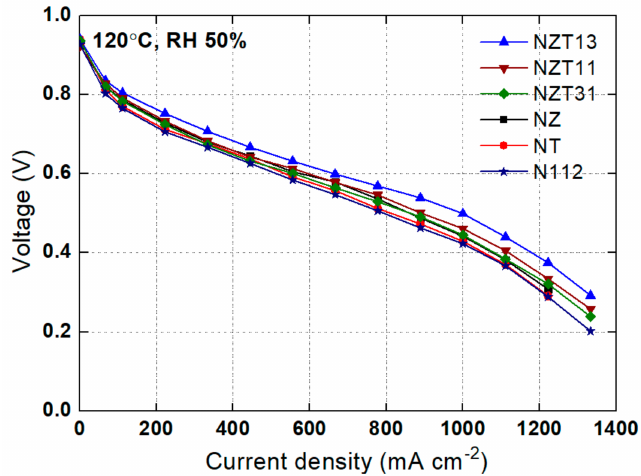
Figure 4. Polarization curves for membranes at 120 ◦ C, RH 50%, 2